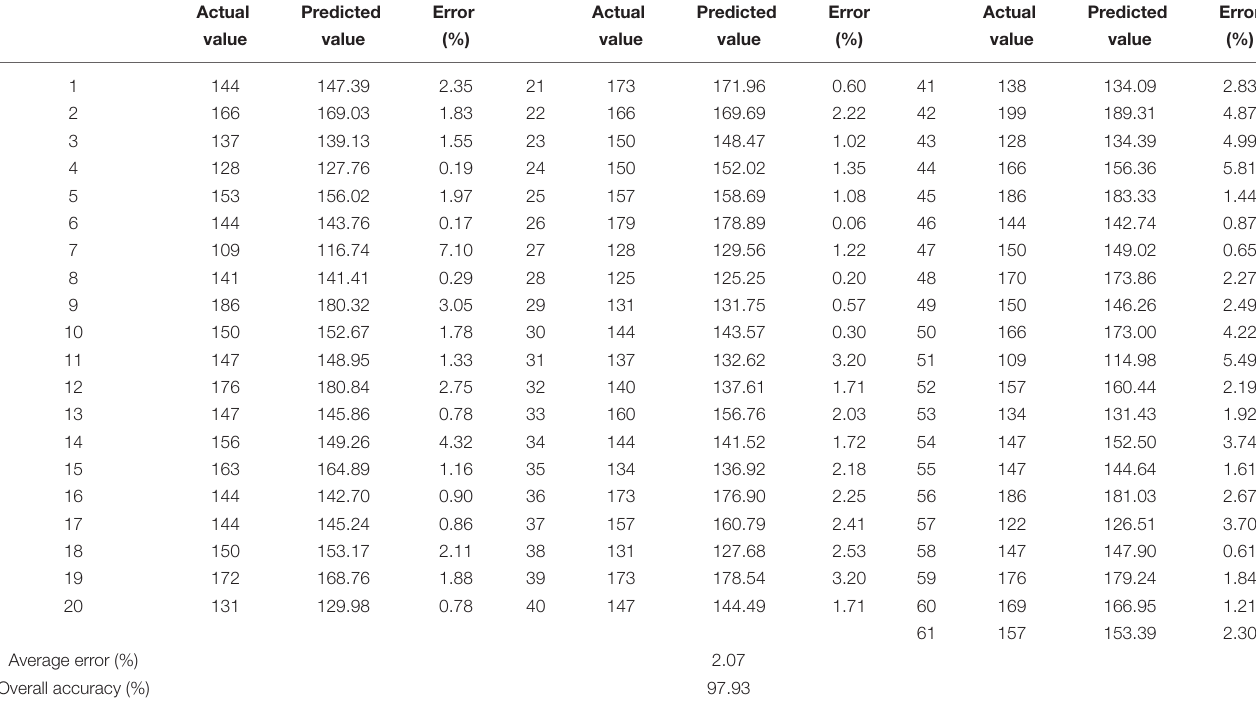
TABLE 3 | Mental health diagnosis